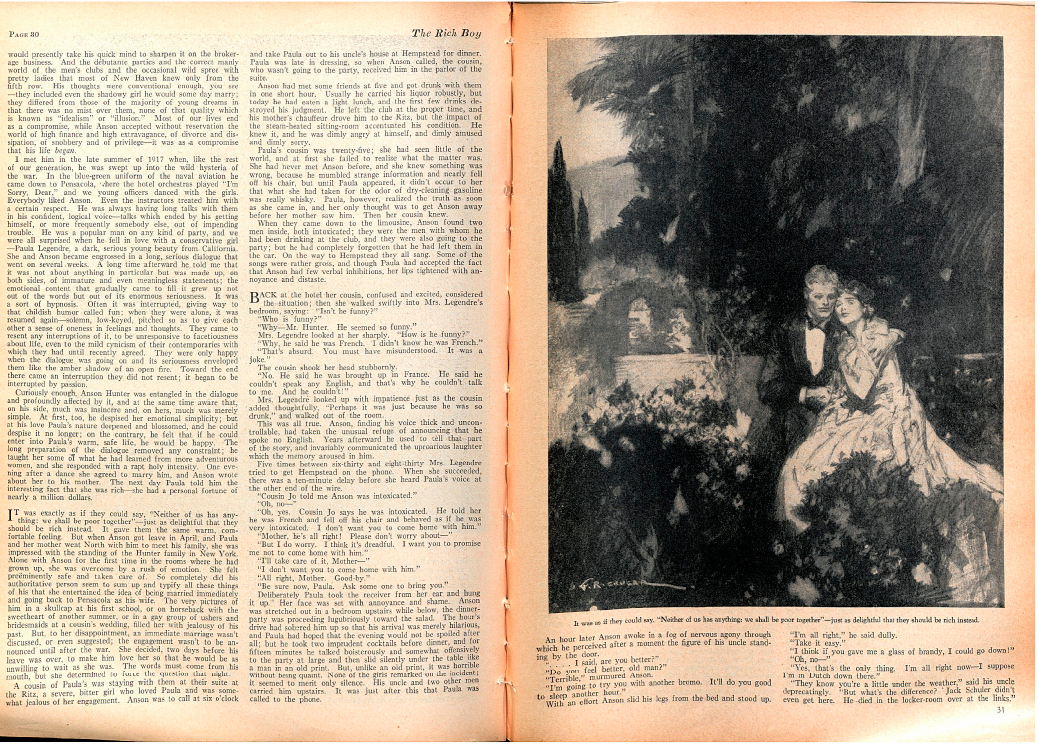
Figure 2. “The Rich Boy” as it first appeared in the January 1926 issue of Red Book Magazine (Fitzgerald 1926a), pp. 30–31.